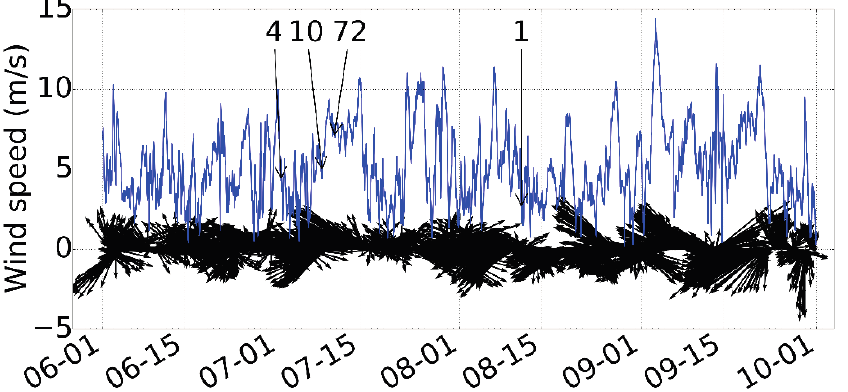
Figure 11. Time-series of wind speed and direction for the Barrow study area from 1 June to 30 September